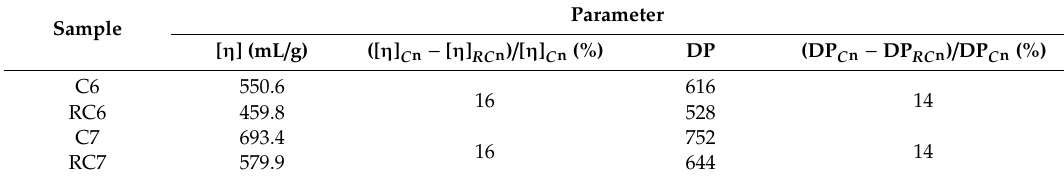
Table 6. Comparison of the intrinsic viscosity and DP between the original cellulose solution and cellulose solution after regeneration.